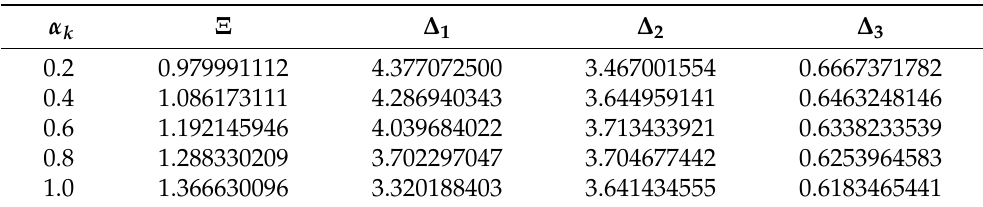
Table 2. Numerical values of Ξ and ∆ i , i = 1,2,3, for α k ∈ { 0.2,0.4,0.6,0.8,1.0 } when φ k ( t ) =